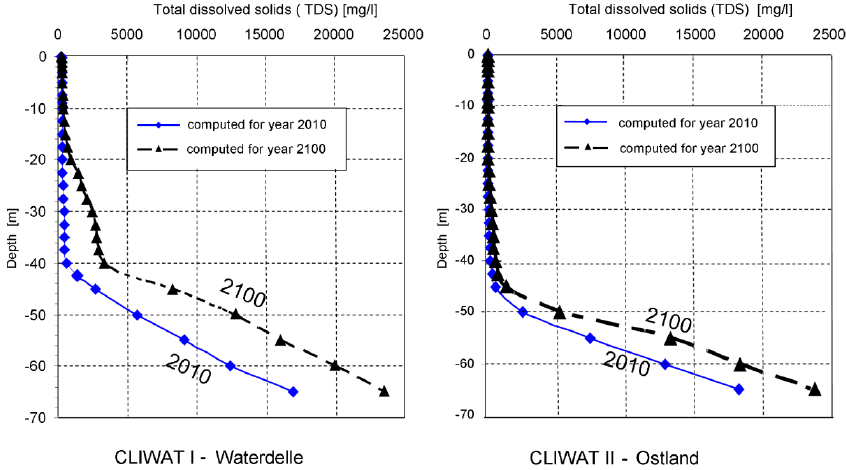
Fig. 19. Spatiotemporal evolution of the vertical mass concentration (TDS) for the years 2010 and 2100 at the wells CLIWAT I and II. The concentrations are computed using the groundwater model.